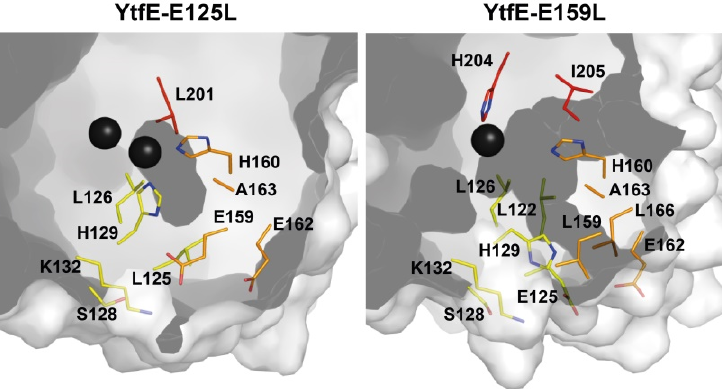
Figure 4. Structural comparison of the iron channel region in YtfE-E125L and YtfE-E159L. In YtfE- E125L a small cavity is present nearby the di-iron center, but the channel formation becomes blocked when leucine replaces E125. In YtfE-E159L, a channel entrance formed by residues E162, L166, and E125, still connects the external surface to the mononuclear iron center. Adapted from [40]. Prior studies indicated that H129 is the only histidine ligand involved in the control of the iron donation capability of YtfE, as its replacement for a leucine residue produces a protein unable to restore the aconitase activity [39]. Interestingly, H129 forms an H-bond with E159 (H129 N δ 1 . . . E159 O ε 1 2.66 Å). Substitution of E159 by leucine caused the side chain